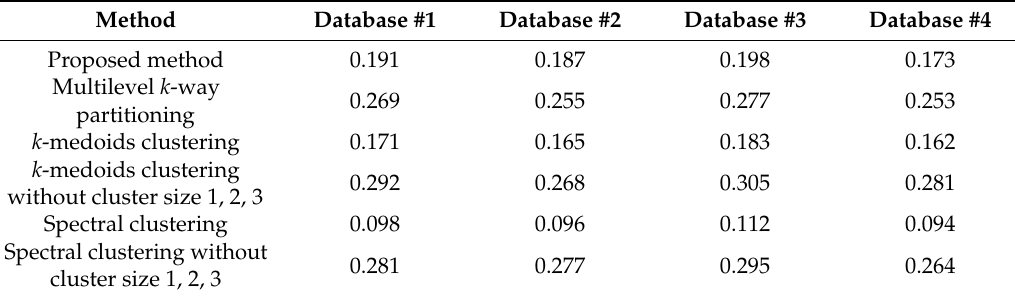
Table 5. The mean intra-cluster distance of the proposed method and three clustering approaches for the four data